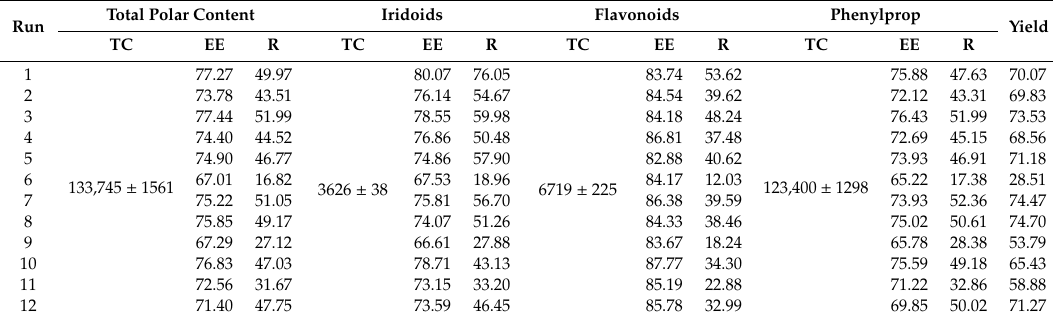
Table 3. Responses of spray drying process in Inulin